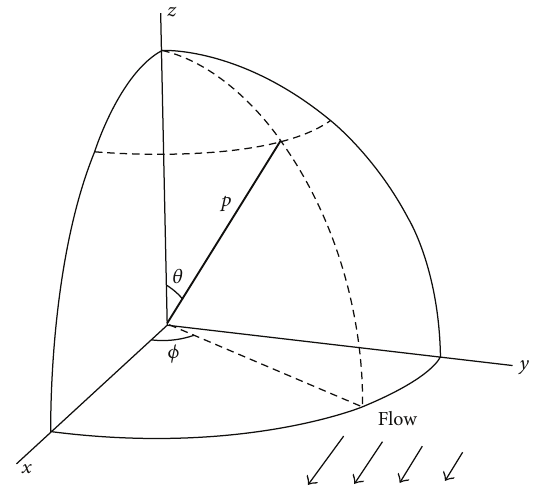
Figure 2: Schematics of fiber orientation. The bold line segment denotes the fiber orientation